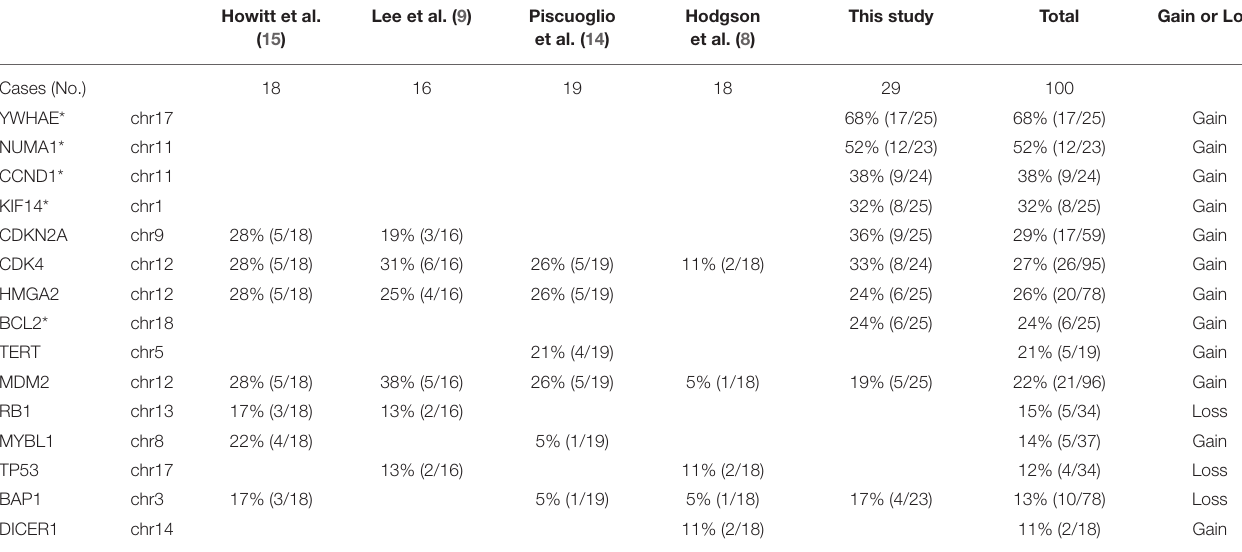
TABLE 2A | Frequently altered gene products of CNV confirmed by IHC examination in MAS.